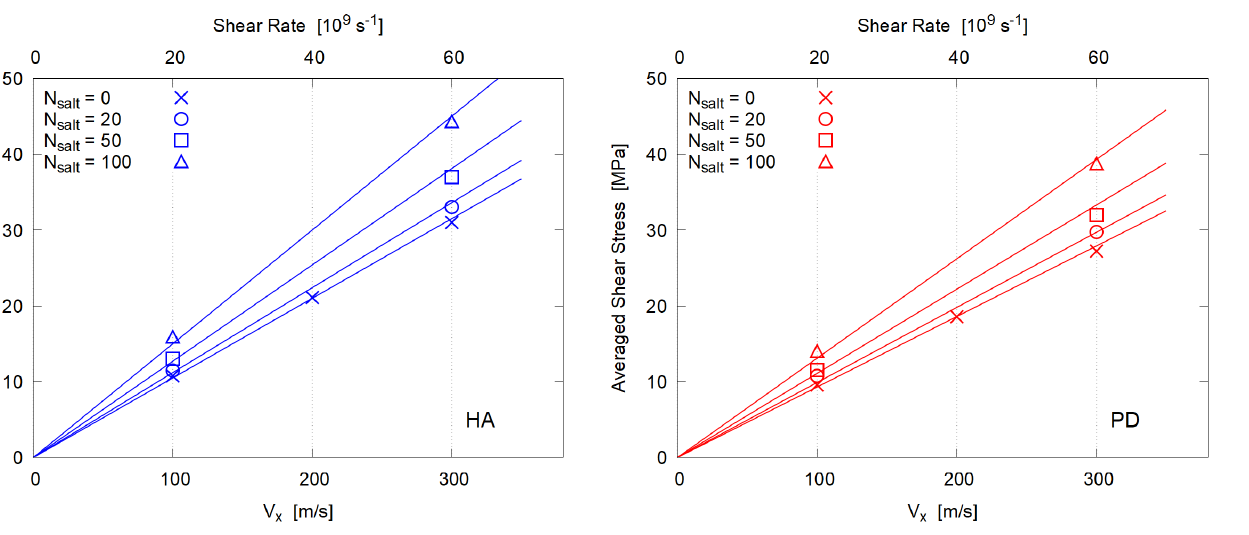
Figure 12. Shear rate dependence of the averaged shear stress.